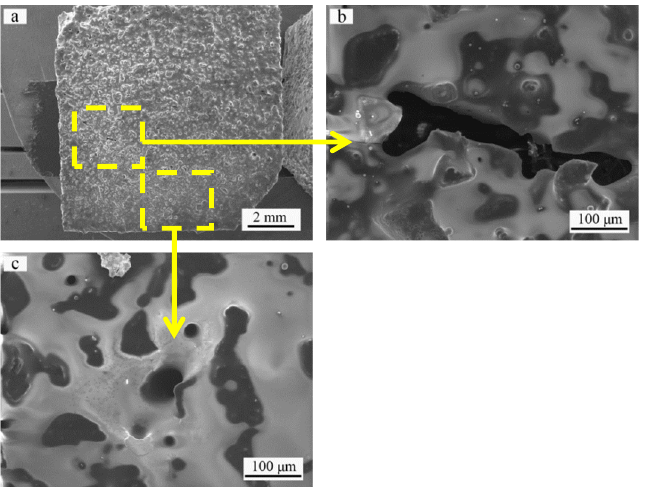
Figure 7. Surface morphology of SiC coating: ( a ) after oxidation at 1773 K in air for 20 h; ( b , c ) are the magnified SEM images of the selected area in ( a ).